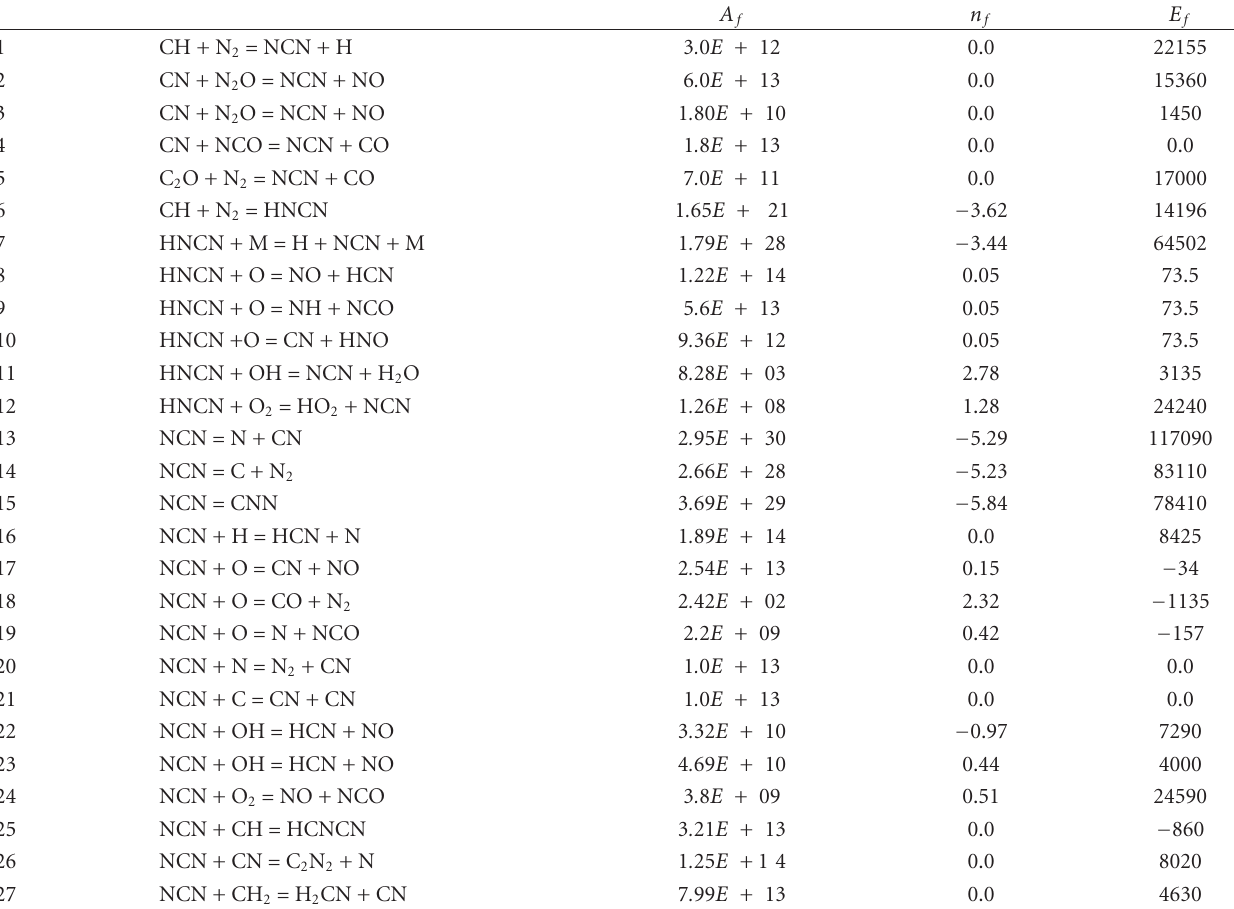
Table 2: Elementary steps in the NCN pathway of prompt NO formation. The forward reaction rate is given by k f = A f T n f exp( − E f /RT )